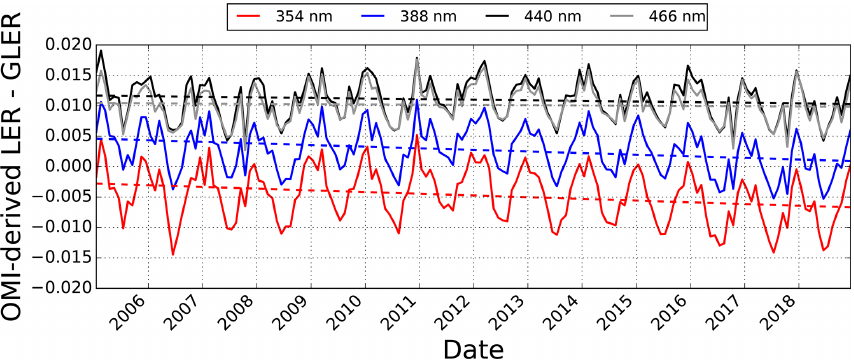
Figure 10. Trend in the difference between the monthly mean GLER and the OMI-derived LER for the same location as in Fig. 9 at UV and Vis wavelengths for row 10. Data are filtered to remove clouds with the Raman-based